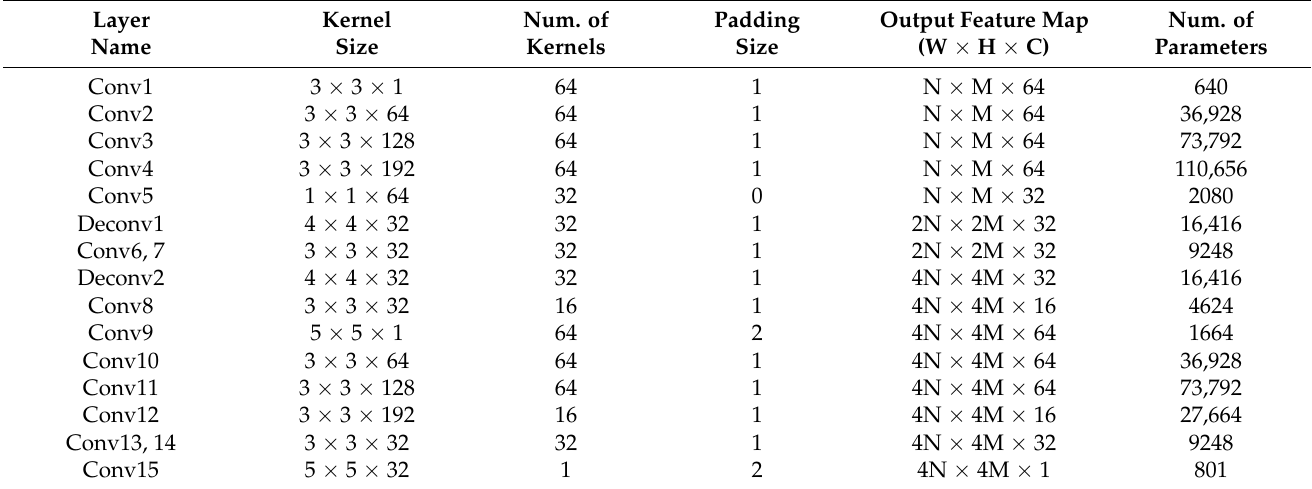
Table 1. Analysis of network parameters in SR-ILLNN.